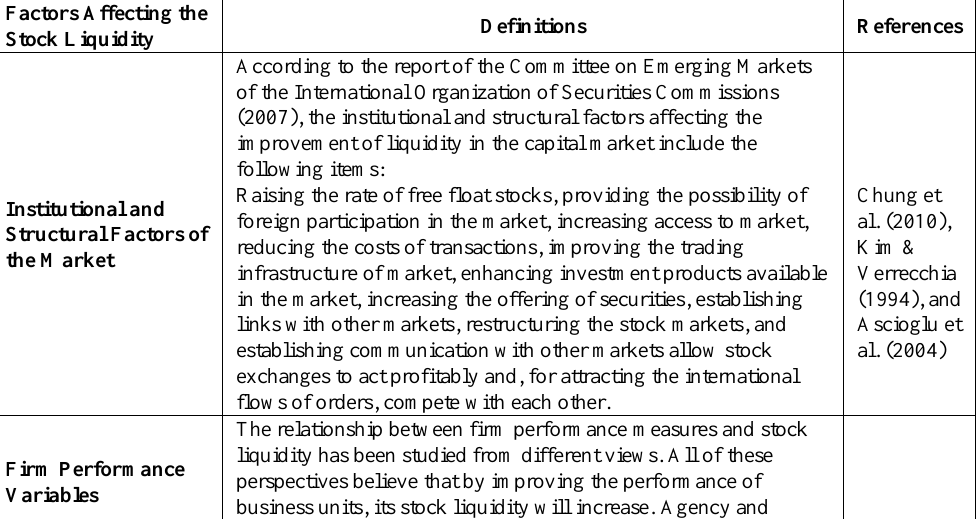
Table 1. Factors Affecting the Stock